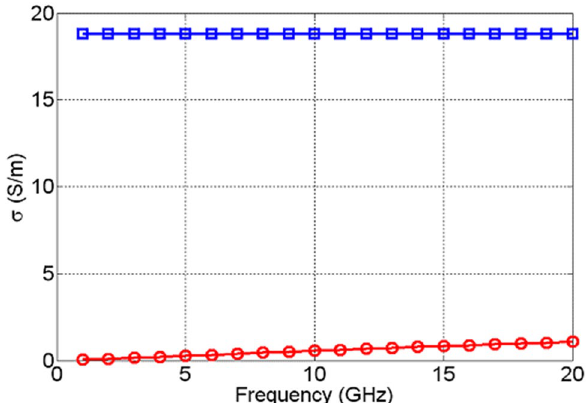
Figure 19. Extracted conductivities of NiO in ON state (red circles) and TiO 2 in ON state (blue